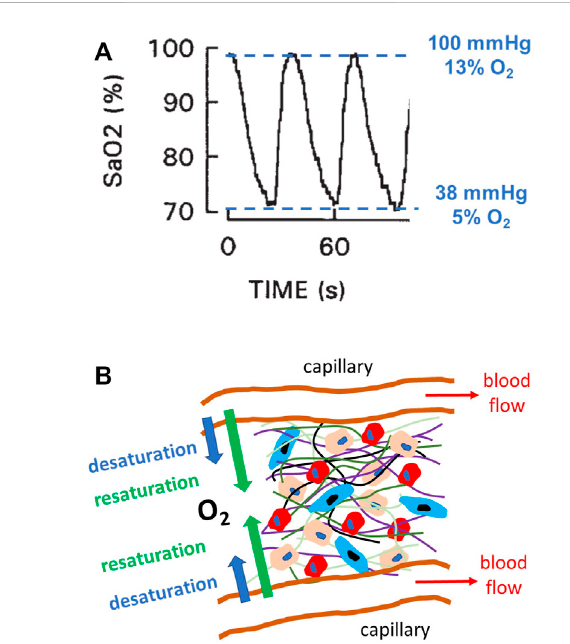
FIGURE 1 Intermittent hypoxia in obstructive sleep apnea (OSA). (A) Example of a recording of arterial oxygen saturation (SaO 2 ) measured by pulse oximetry in a patient with severe OSA, showing the fast and marked hypoxemic events characterizing this disease. The fi gure also indicates the values of O 2 partial pressure, and thus O 2 percentage (for 760 mmHg atmospheric pressure), corresponding to the maximum and minimumlevelsofSaO 2 .Modi fi edfromReference(Farréetal.,1998)and reproduced with permission. (B) Diagram representing a section of the parenchymal cells in any organ/tissue where different cell types (represented by different sizes and colors) reside within an extracellular matrix (different fi bers represented by different color lines). This 3D environment is perfused by O 2 from the arterial blood circulating through systemic capillaries. Given the intermittent hypoxemia, the magnitude ofO 2 diffusion throughthecapillarywallcycles(desaturation and resaturation), and cells are subjected to intermittent hypoxia caused by hypoxemic events (A) .